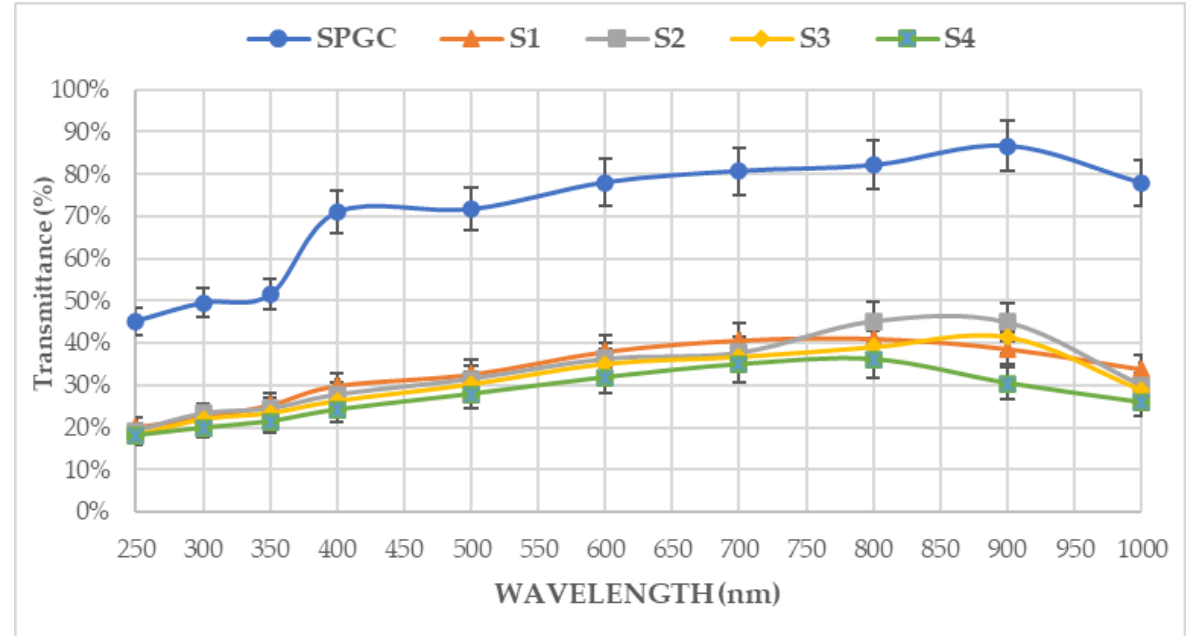
Figure 4. UV–Vis transmittance percentage of biodegradable starch/polyvinyl alcohol wound dress- ings before (SPGC) and after adding four different amounts of nano-sized ZnO particles to the ma- terial (S1–S4).